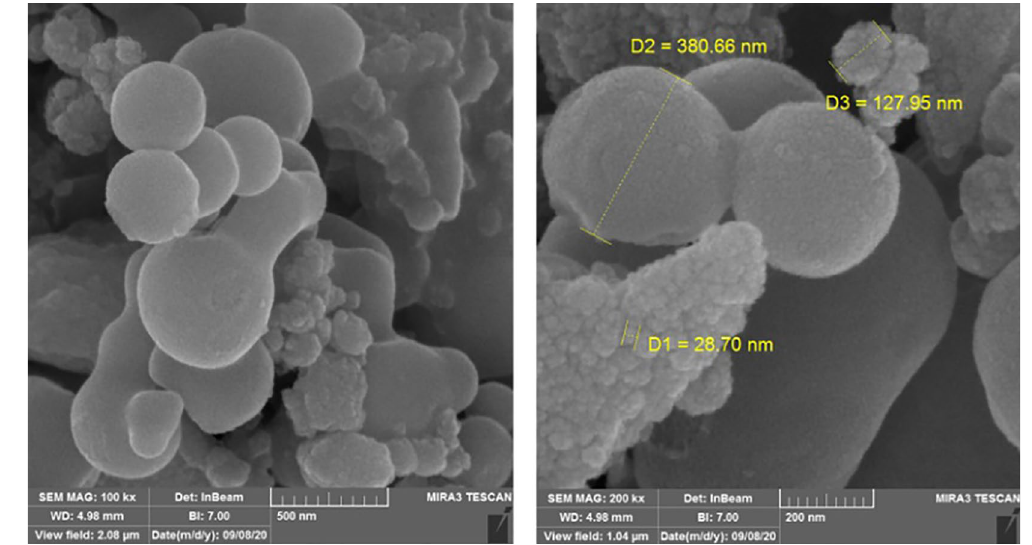
Figure 4. SEM images of Fe 3 O 4 @SiO 2 @PCLH-TFA.